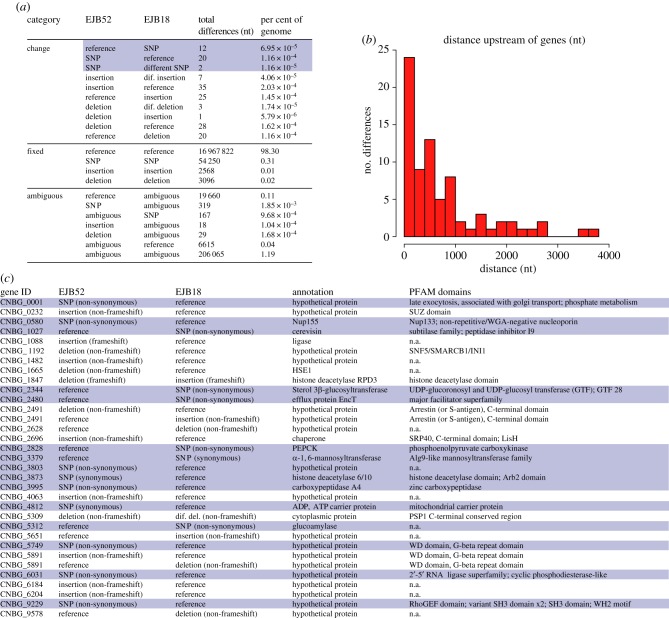
Genetic changes that underlie the increased hypervirulence of C. gattii outbreak strains were identified by comparing EJB52 (low per cent mitochondrial tubularization and IPR) and EJB18 (high tubularization and IPR). (a) Summary of all genetic differences between EJB52 and EJB18. Single base changes are shown in blue (b) Distance of intergenic variants between EJB52 and EJB18 to any upstream genes. (c) Thirty-one genes with genetic differences were uniquely identified between EJB52 and EJB18. Genes are numerically ordered by their locus ID, and single base changes are highlighted. (Online version in colour.)